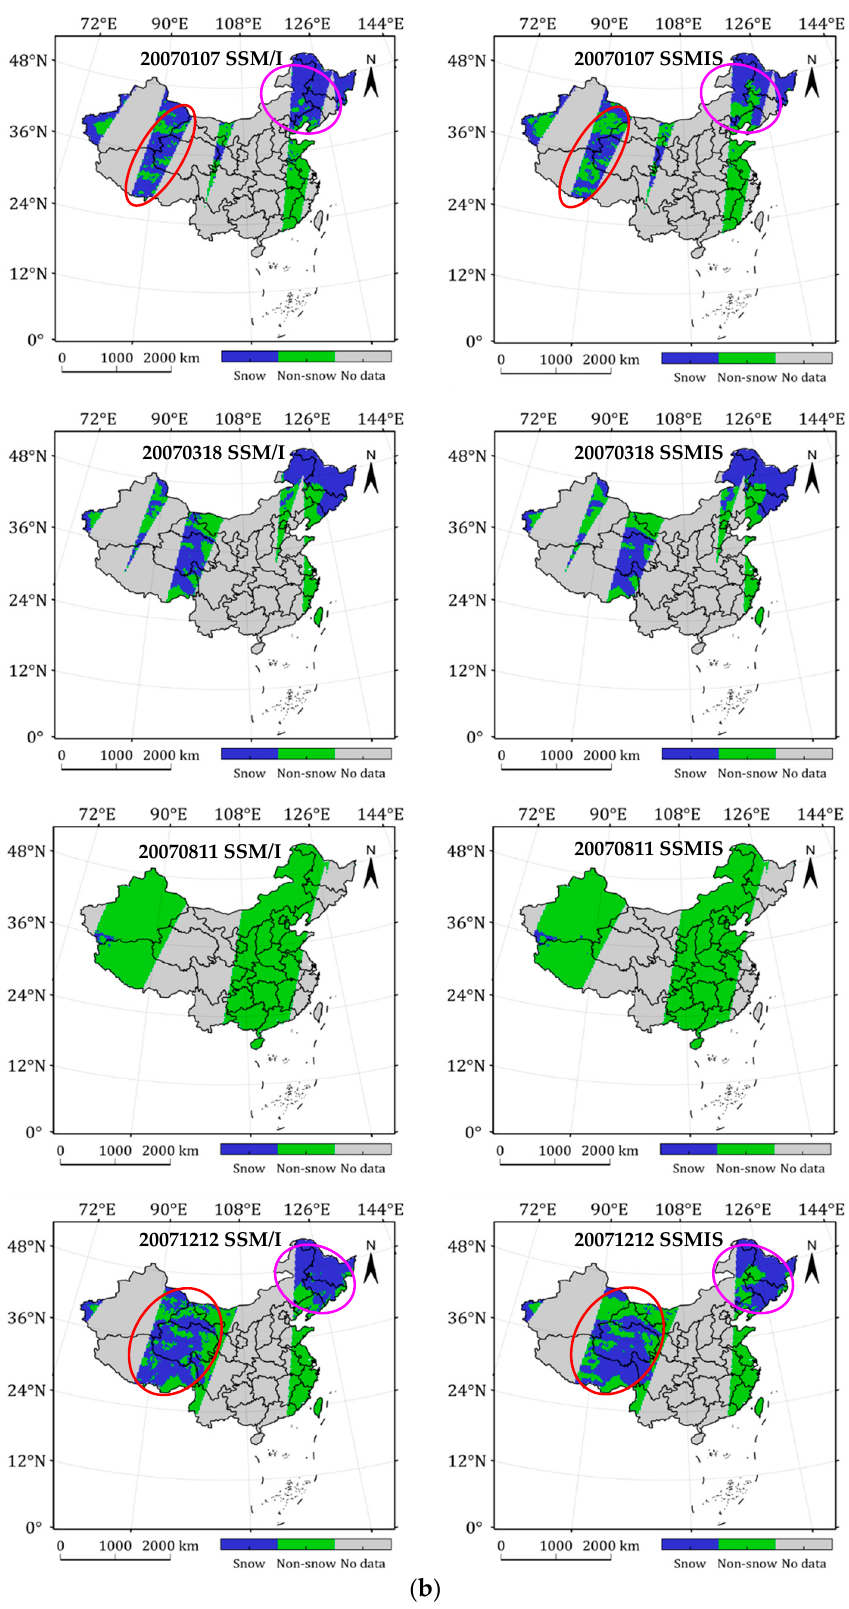
Figure 8. Comparison of snow cover detection method for SSM / I and SSMIS: ( a ) Li algorithm; ( b ) Grody algorithm. Blue and green represent snow cover and snow-free, respectively. Gray denotes orbit gap from SSM / I or SSMIS. Left: SSM / I; right: SSMIS.